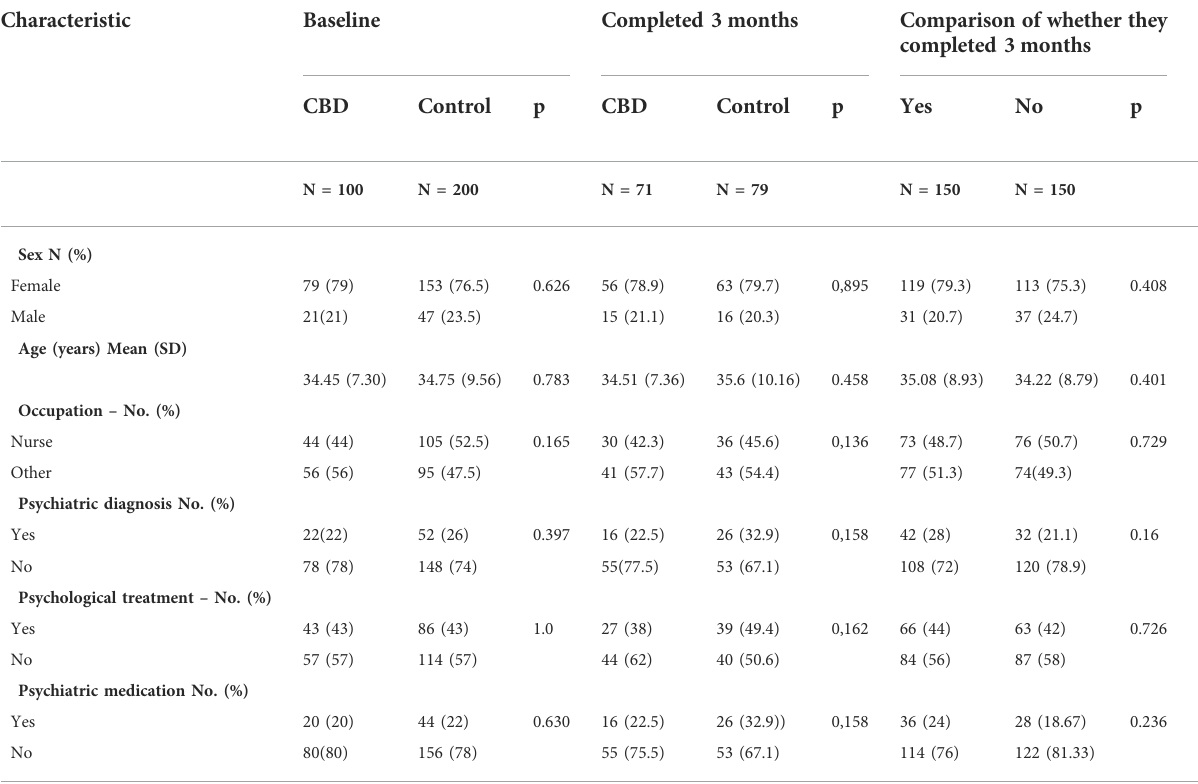
TABLE 1 Demographic and Clinical Characteristics of Participants.